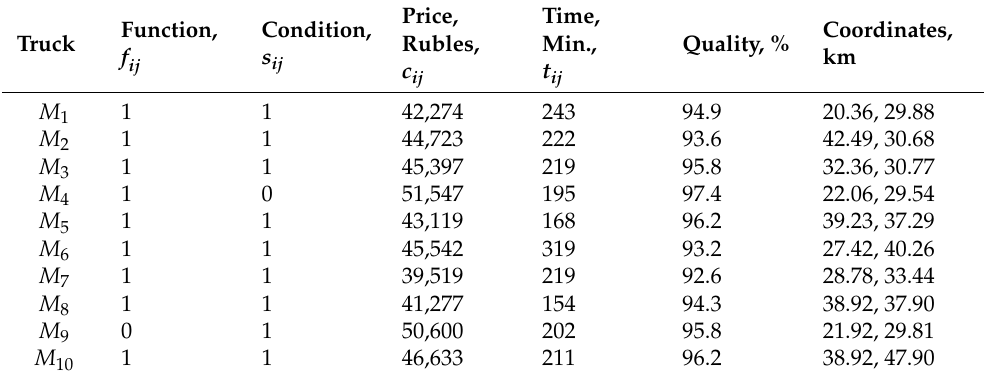
Table 1. Parameters of 10 trucks.